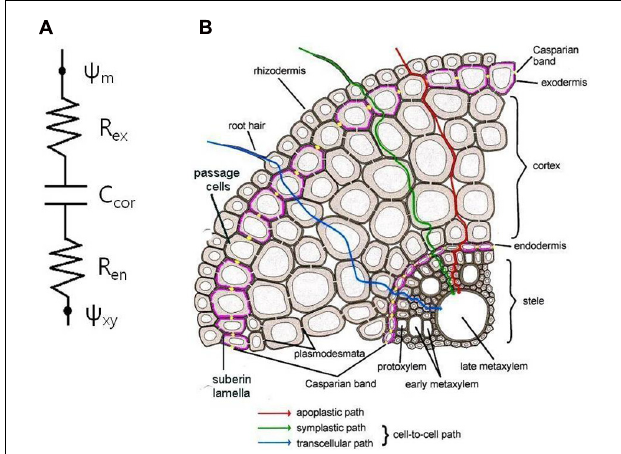
FIGURE 1 | Extended composite transport model. (A) Electric analogy with series of resistance–capacitor–resistance. (cid:57) m , water potential in medium; (cid:57) xy , water potential in xylem; R ex , exodermis resistance; R en , endodermis resistance; C cor , cortex capacitance. (B) Schematic diagram of a root cross-section showing pathways of water and solute transport into the stele. Casparian bands (yellow dots) and suberin lamellae (pink lines) in the endo- and exodermis interrupt water and solute transport into the